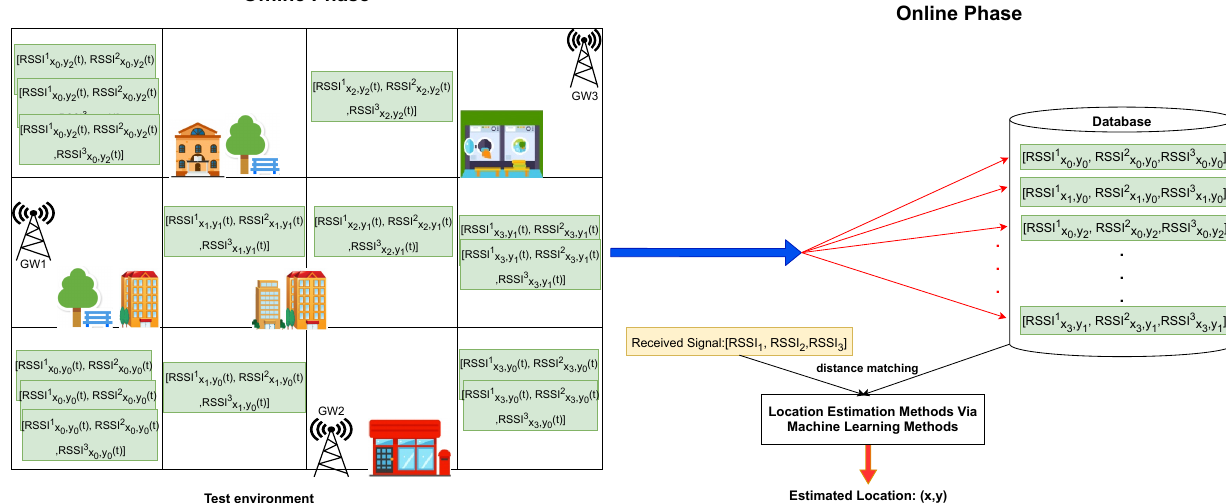
Figure 4. Fingerprint-based localization